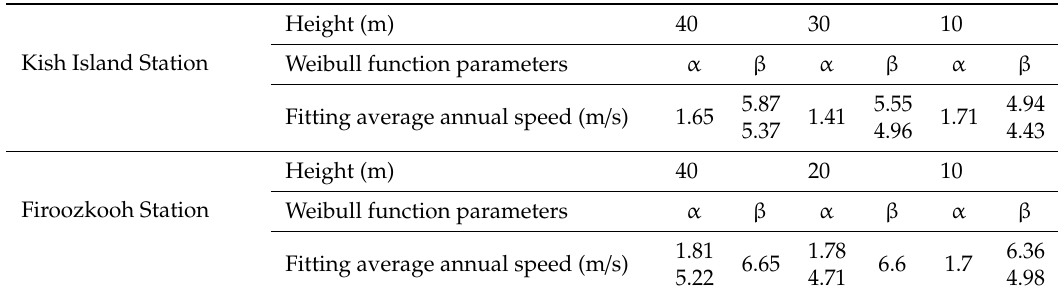
Table 3. Weibull function parameters and average annual wind